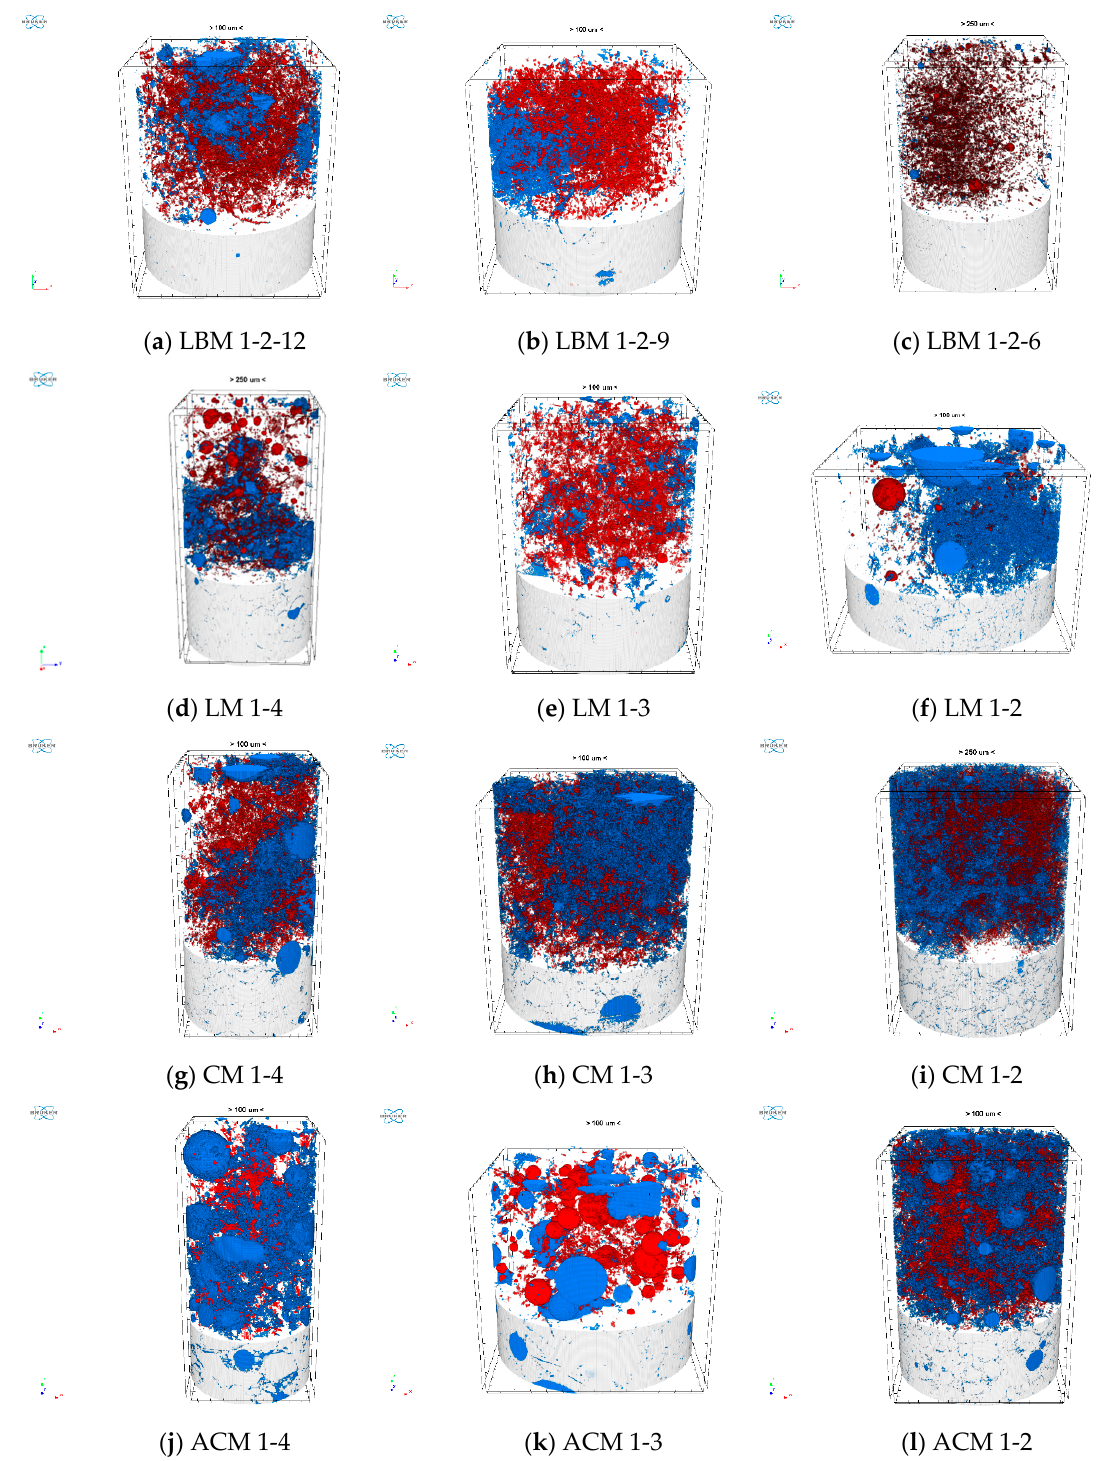
Figure 2. Nanotomography images of the mortar samples: red color-closed pores and blue color-open pores. ( a ) sample of mortar type LBM 1-2-12; ( b ) sample of mortar type LBM 1-2-9; ( c ) sample of mortar type LBM 1-2-6; ( d ) sample of mortar type LM 1-4; ( e ) sample of mortar type LM 1-3; ( f ) sample